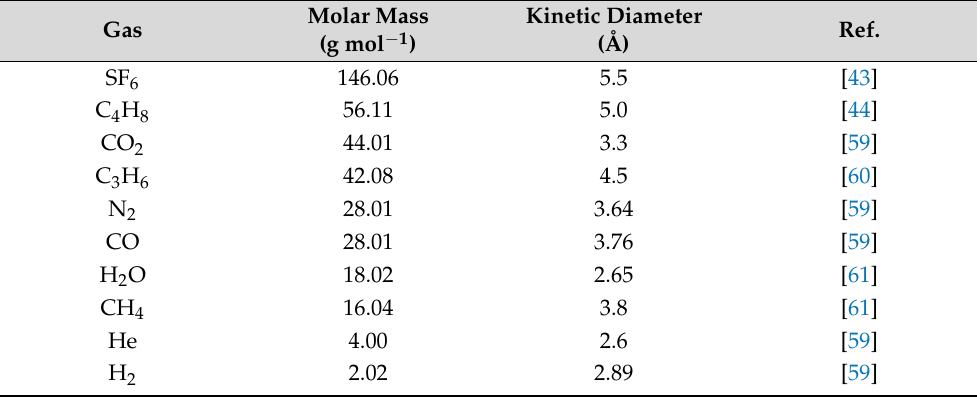
Table 3. Probe gases used for investigation of the gas permeation properties and determination of the ideal selectivity values of the studied Carbon/Vycor ® membranes, their molar weights, and kinetic diameters.